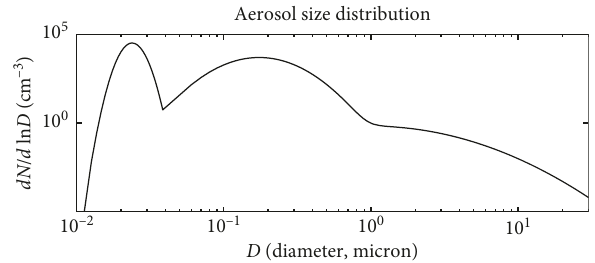
Figure 2: Initial aerosol size distribution at the altitude of 0.5km. N represents the aerosol number concentration per unit volume of air and D the aerosol